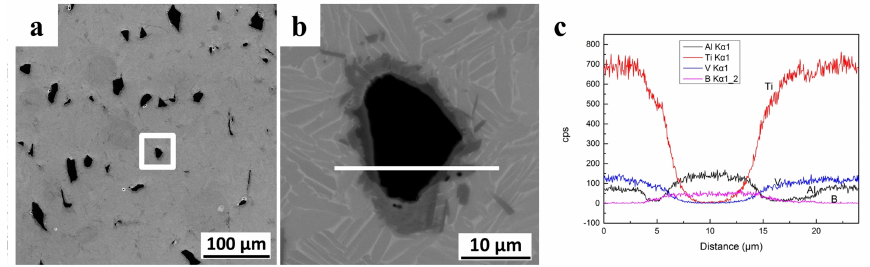
Figure 4. ( a , b ) The selected area of EDS analysis; ( c ) The EDS line of the micro-area at the second phase